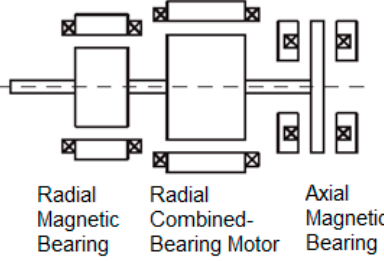
Figure 3. Structure of radial combined magnetic bearing motor.